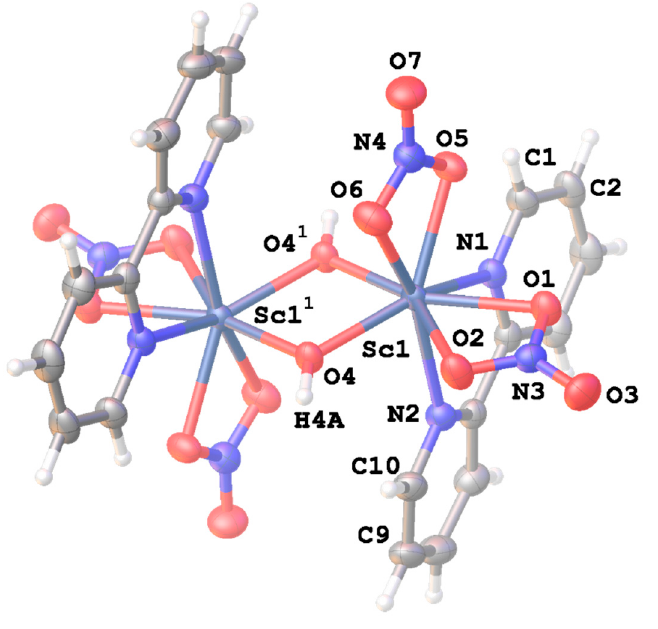
Figure 1. The molecular structure of the dimeric [(bipy)(NO 3 ) 2 Sc( μ‐ OH) 2 Sc(NO 3 ) 2 (bipy)] showing the atom numbering scheme. The atoms with the superscript 1 are related to the atoms in the asymmetric unit by the symmetry operator − x, − y, 1 − z. The displacement ellipsoids are set at 50% probability. Selected bond parameters: Bond lengths: Sc1 ‐ O1, 2.3115(17), Sc1 ‐ O2, 2.2958(18), Sc1 ‐ O4, 2.0974(15), Sc1 ‐ O4 1 , 2.0413(16), Sc1 ‐ O5, 2.2702(17), Sc1 ‐ O6, 2.2558(19), Sc1 ‐ N1, 2.3744(19), Sc1 ‐ N2, 2.3261(19), Sc1 ∙∙∙ Sc1 1 , 3.3372(9) Å; Bond angles: O2 ‐ Sc1 ‐ O1, 55.05(6), O6 ‐ Sc1 ‐ O5, 55.76(6), N2 ‐ Sc1 ‐ N1,69.09(6), O4 1 ‐ Sc1 ‐ O4, 72.52(7), Sc1 1 ‐ O4 ‐ Sc1, 107.48(7)°. Atoms denoted “ 1 ” are related by the symmetry operation − x, − y, 1 − z.